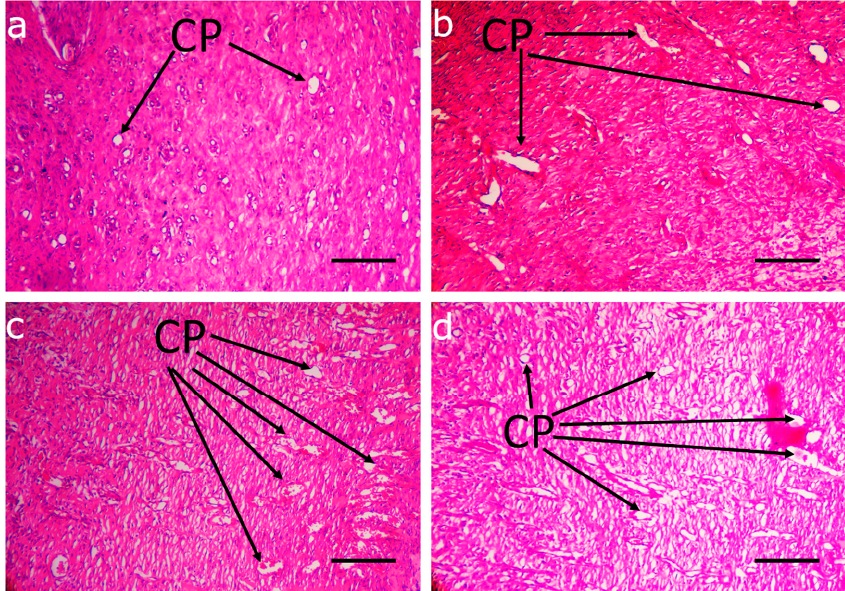
Figure 5. Capillary formation in deep dermal layers of different implantation groups on day 14. ( a ) CPR; ( b ) CP500; ( c ) CP1000; ( d ) control. Capillary hyperplasia (arrows) was markedly observed in CP1000 group and in control group. Scale bar: 30 µm.